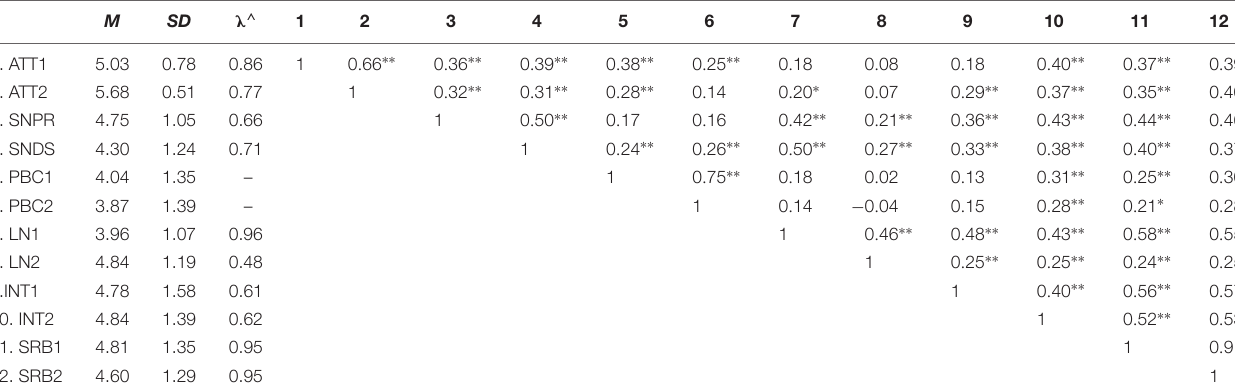
TABLE 3 | Means ( M ), standard deviations ( SD ), standardized structural coefficients ( λ ), and Pearson’s correlations for measures of recycling attitudes (ATT), subjective norms (SN), PBC, local n o rms (LN), intentions (INT), and self-reported behavior (SRB), used in the test of the measurement model on sample 2 ( N =